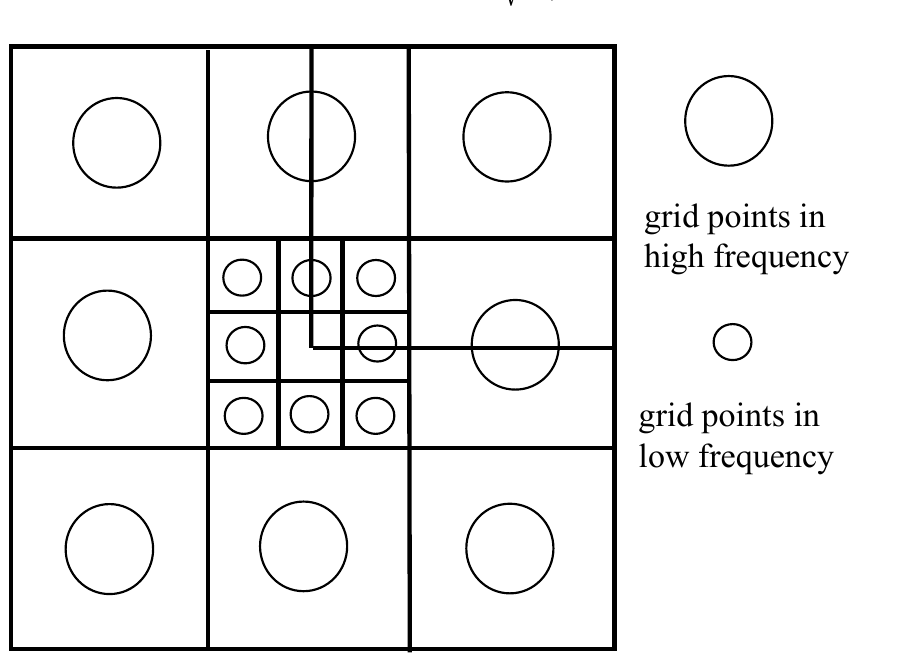
Figure 6. Schematic diagram of sub-harmonic compensation.